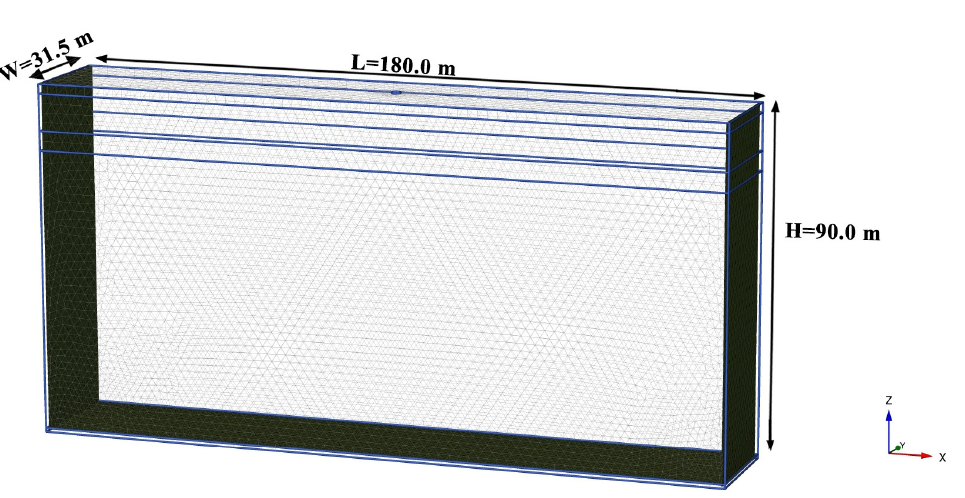
Figure 15. Finite element mesh.